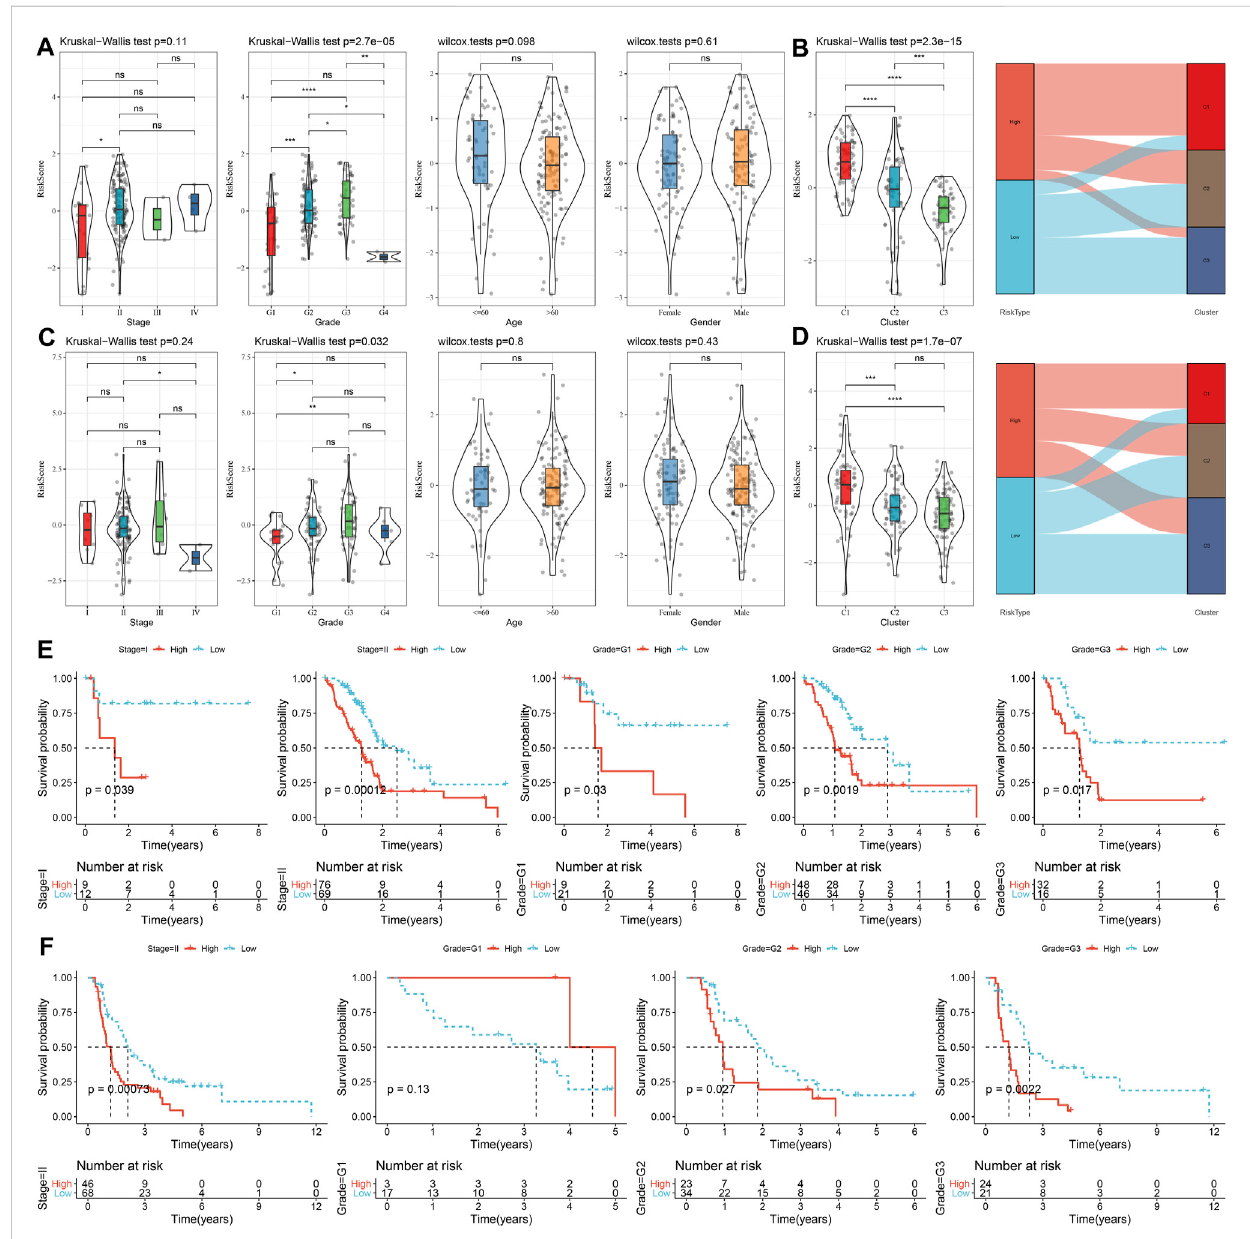
FIGURE 9 The distribution and predictive capability of the risk score in sub-population with distinct clinicopathological features. (A) and (C) Differences in risk score among different clinicopathological groups in the TCGA-PAAD and PACA-CA cohorts, respectively; (B) and (D) Difference in risk score among different molecular subtypes in the TCGA-PAAD and PACA-CA cohorts, respectively; (E) and (F) K-M curve of risk score-derived groups in different clinicopathological groups the TCGA-PAAD and PACA-CA cohorts,